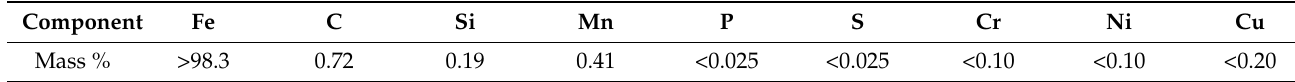
Figure 2. The geometry configuration of strand specimen. Table 1. Composition of selected strand specimen.